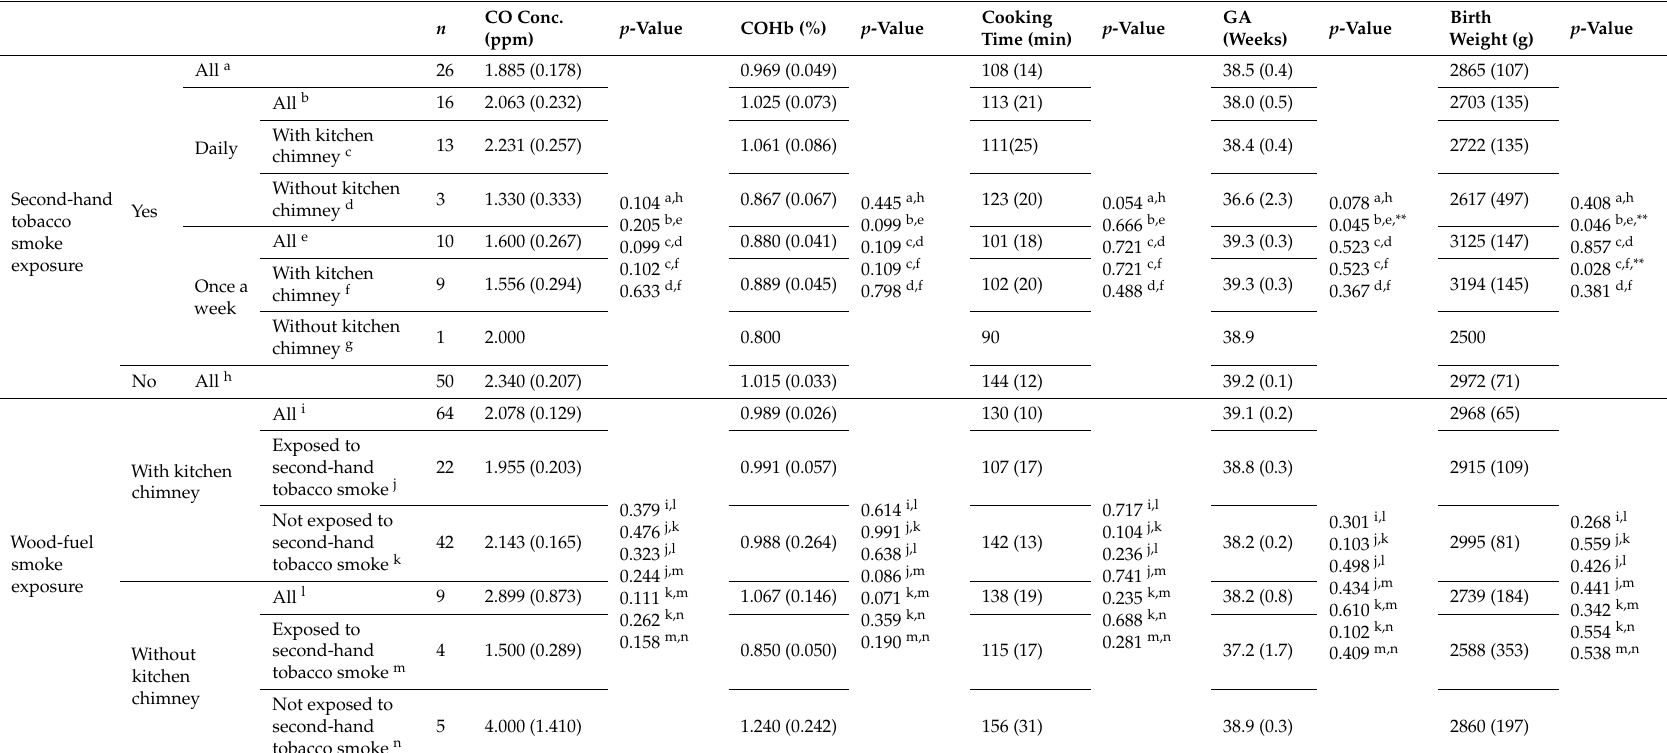
Table 3. Exposure to second hand tobacco smoke and wood fuel smoke and their relations to pregnancy